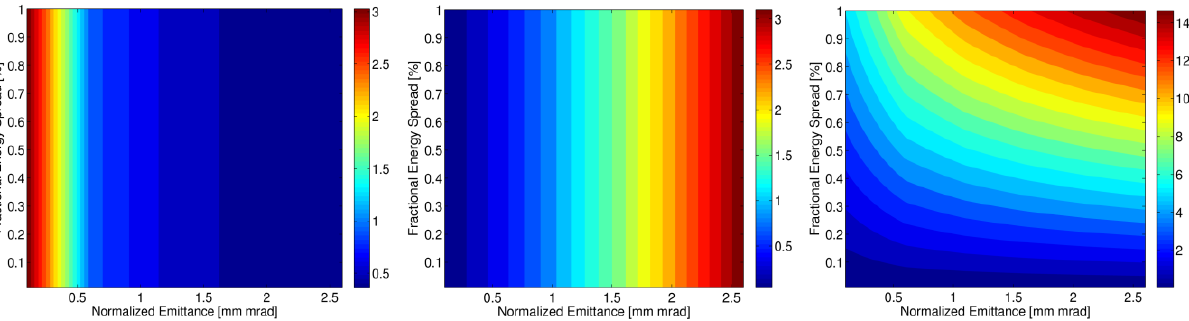
Figure 6. Contour plot of (from ( left ) to ( right ))  d ,  fractional energy spread and normalized transverse emittance (all rms values, see Equation (13)). All other beam and undulator parameters are listed in Table